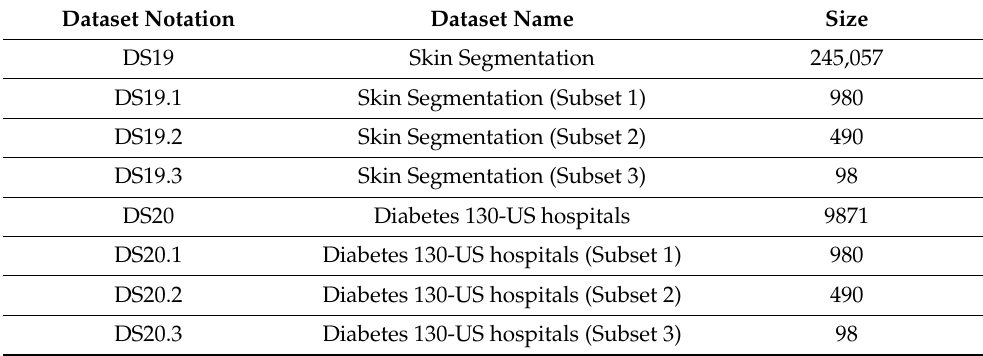
Table 3. Large Datasets and their